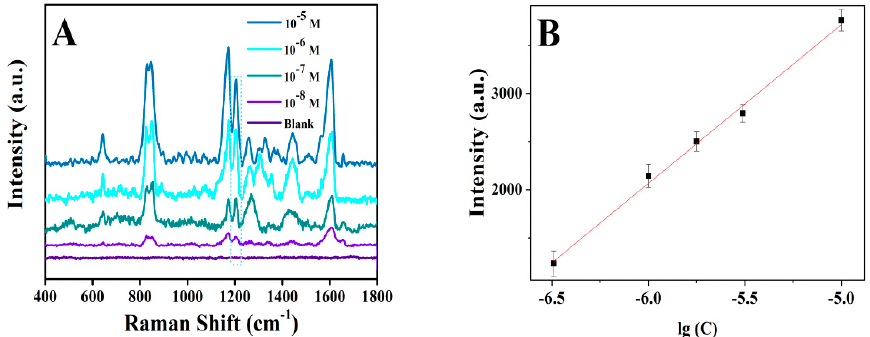
Figure 7. ( A ) Concentration-dependent SERS spectra of tyramine recorded on Co 400 -ZnO/Au substrate. ( B ) Calibration plot based on Raman intensity at 1208 cm − 1 .